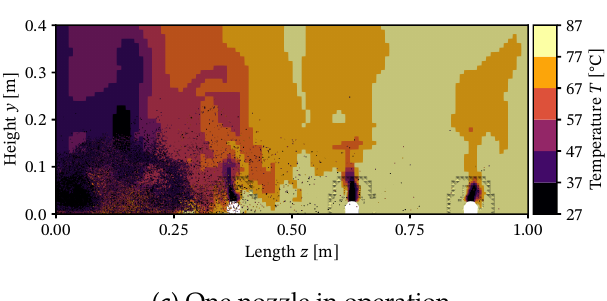
8 20 g min − 1 , where this trend is much more pronounced: The mean evaporation time ×